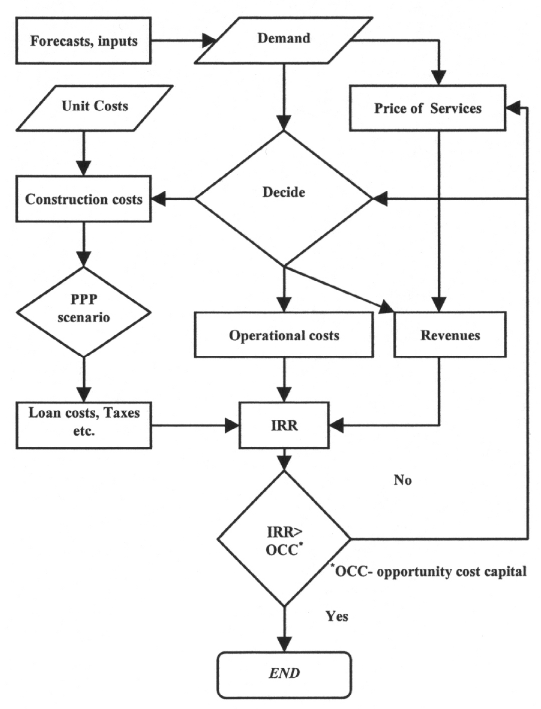
Fig 2. Financial evaluation process for each financial